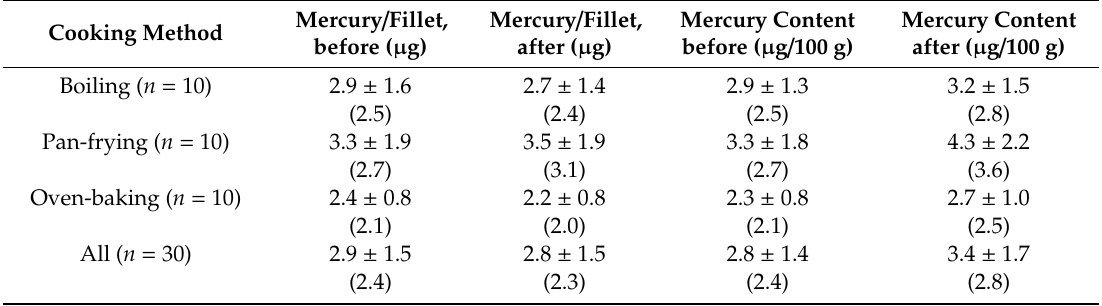
Table 4. Total mercury per fillet ( µ g) and mercury content per 100 g fillet ( µ g / 100 g) in cod fillets before and after the di ff erent cooking methods. Numbers are given as mean ± SD and (median) wet